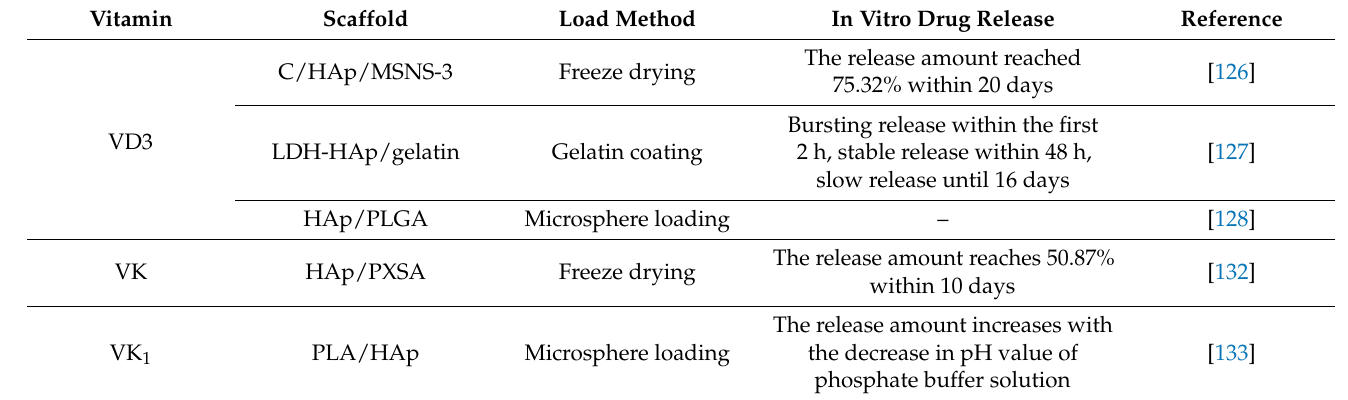
Table 4. Summary of vitamin-loaded n-HAp composites for bone